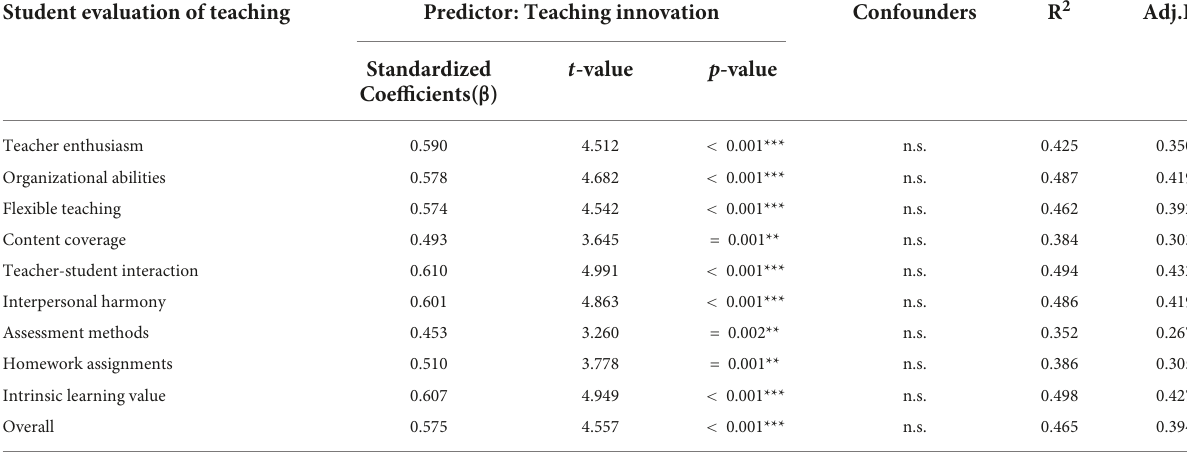
TABLE 5 Associations between teaching innovation and SET in the peri-COVID-19 pandemic period. Student evaluation of